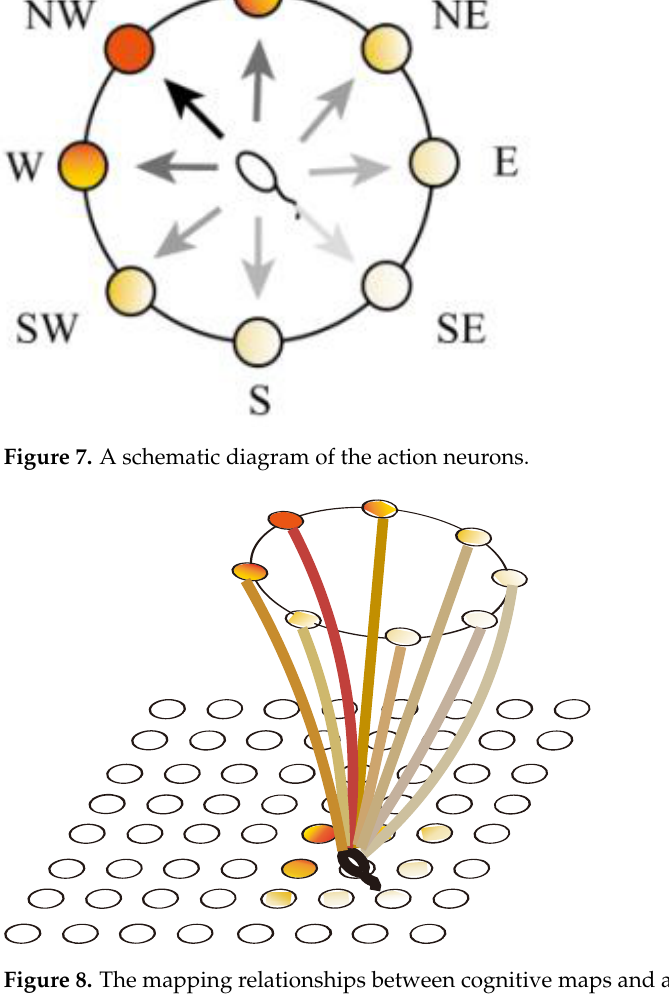
Figure 8. The mapping relationships between cognitive maps and action neurons.